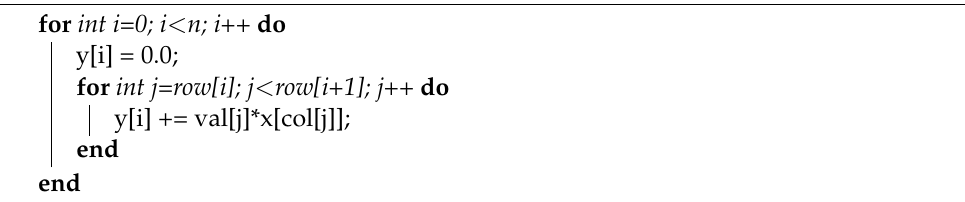
Algorithm 2: Matrix–vector multiplication using CSR format: y and x are, re- spectively, the result vector and the operand